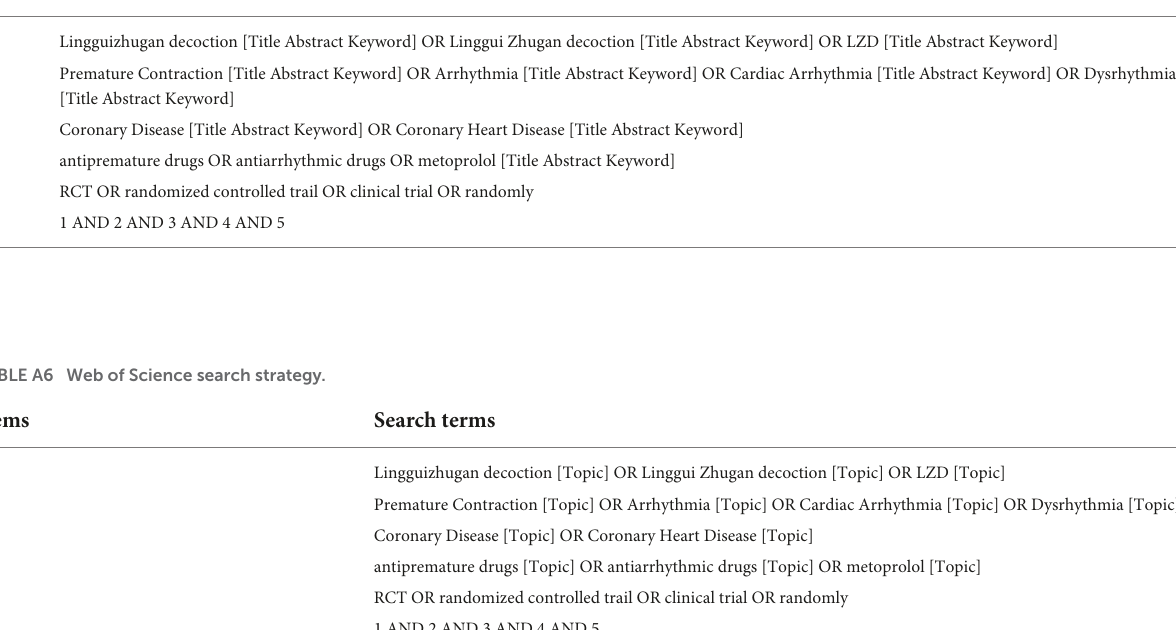
TABLE A5 Cochrane library search strategy.